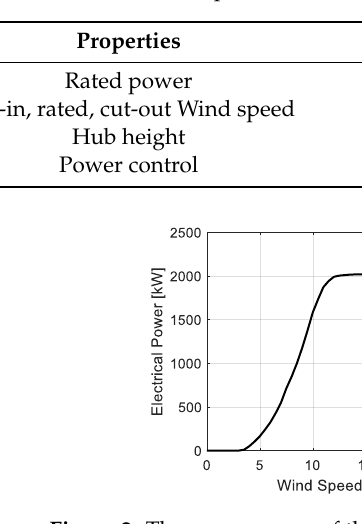
Figure 2. The power curve of the target wind turbine.